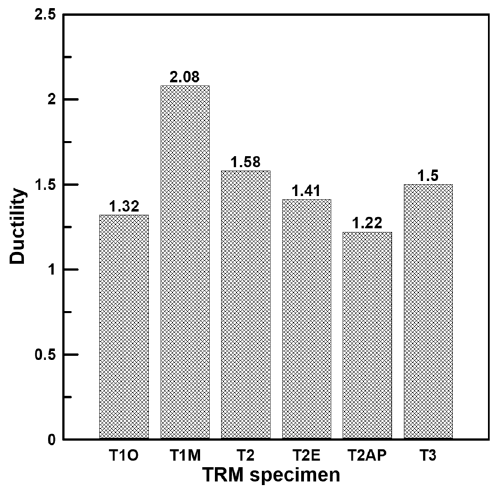
Figure 11. Comparison of ductility index of TRM specimen.